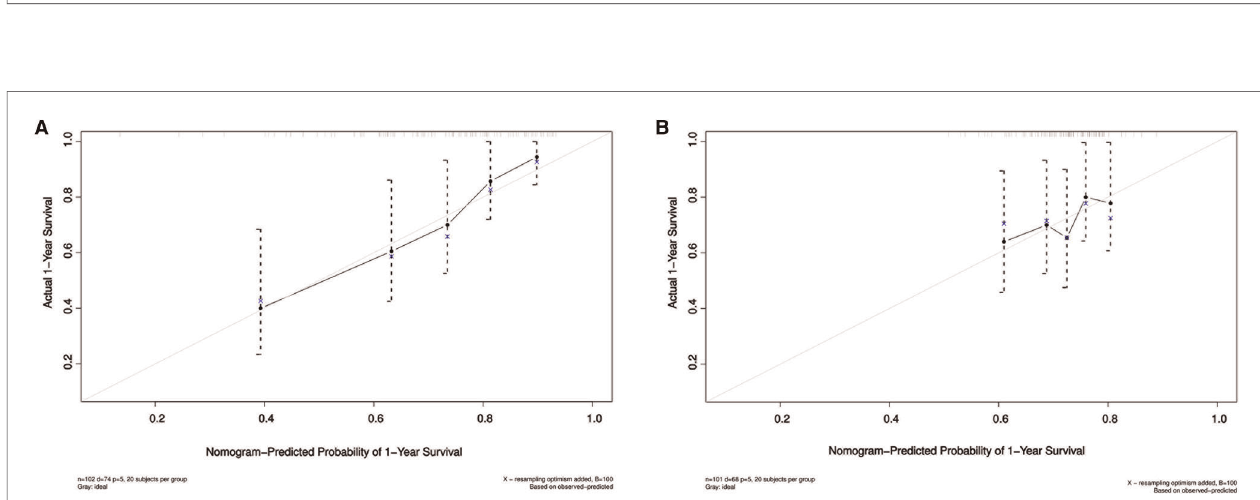
FIGURE 2 | Calibration curves. ( A ) Calibration curves showing the probability of 1-year mortality between the nomogram prediction and the actual observation in training set; ( B ) Calibration curves showing the probability of 1-year mortality between the nomogram prediction and the actual observation in the validation set. The prediction probability of the nomogram for 1-year mortality was plotted on the X-axis, and the actual probability was plotted on the Y-axis